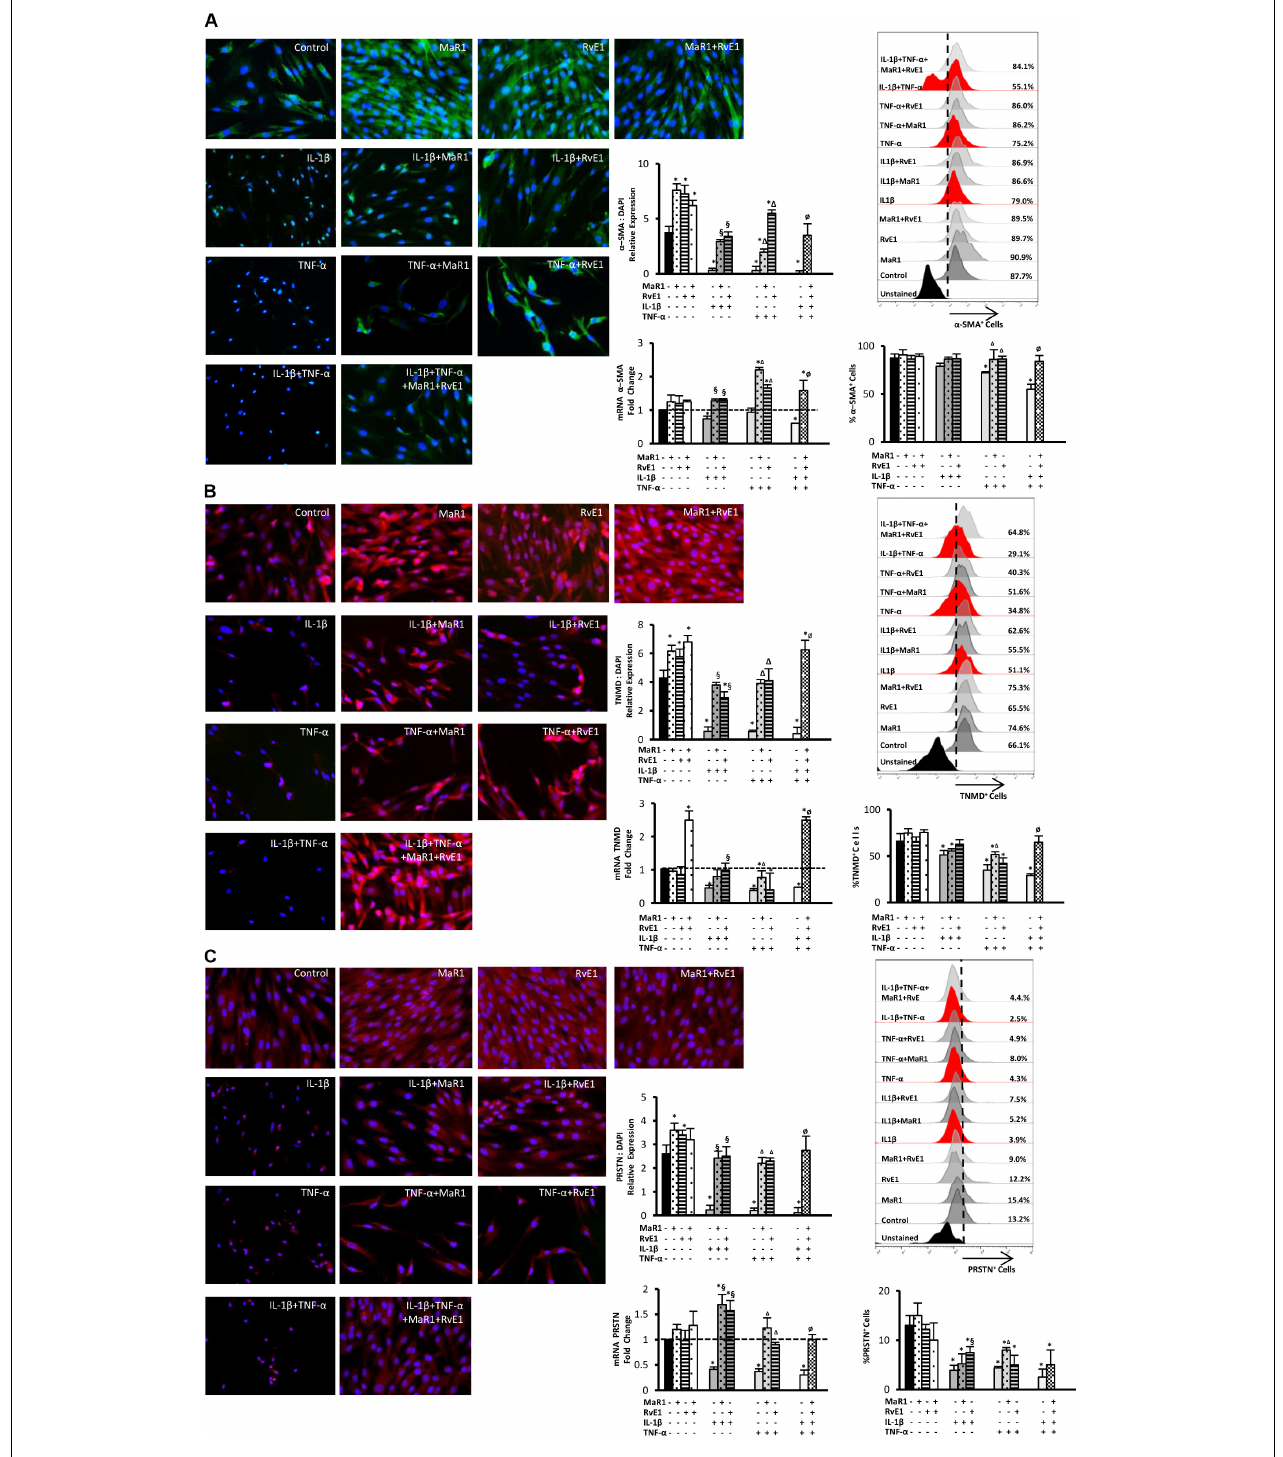
FIGURE 3 | Analysis of the periodontal ligament-like cell markers: α -SMA (A) , tenomodulin (TNMD), (B) , and periostin (PRSTN; C ) after 24 h of stimuli with mediators. Immunofluorescence representative images in 40X magnification. Protein expression was analyzed by immunofluorescence intensity relative expression in relation to DAPI. Relative gene expression (mRNA) was evaluated by qPCR using GAPDH as endogenous control and the (cid:49)(cid:49) CT method. Flow cytometry analysis was used to measure the percentage of positive hPDLSCs for each marker, and unstained cells were used to set positive cell populations. (*) p < 0.05 vs control (unstimulated); (§) p < 0.05 vs IL-1 β treated group; ( (cid:49) ) p < 0.05 vs TNF- α treated group; and ( ø ) p < 0.05 vs IL-1 β +TNF- α treated group. ANOVA with post-hoc test Tukey was used to determine statistical differences between experimental groups at the 0.05 level. Results are presented as mean ± SEM of three independent experiments.